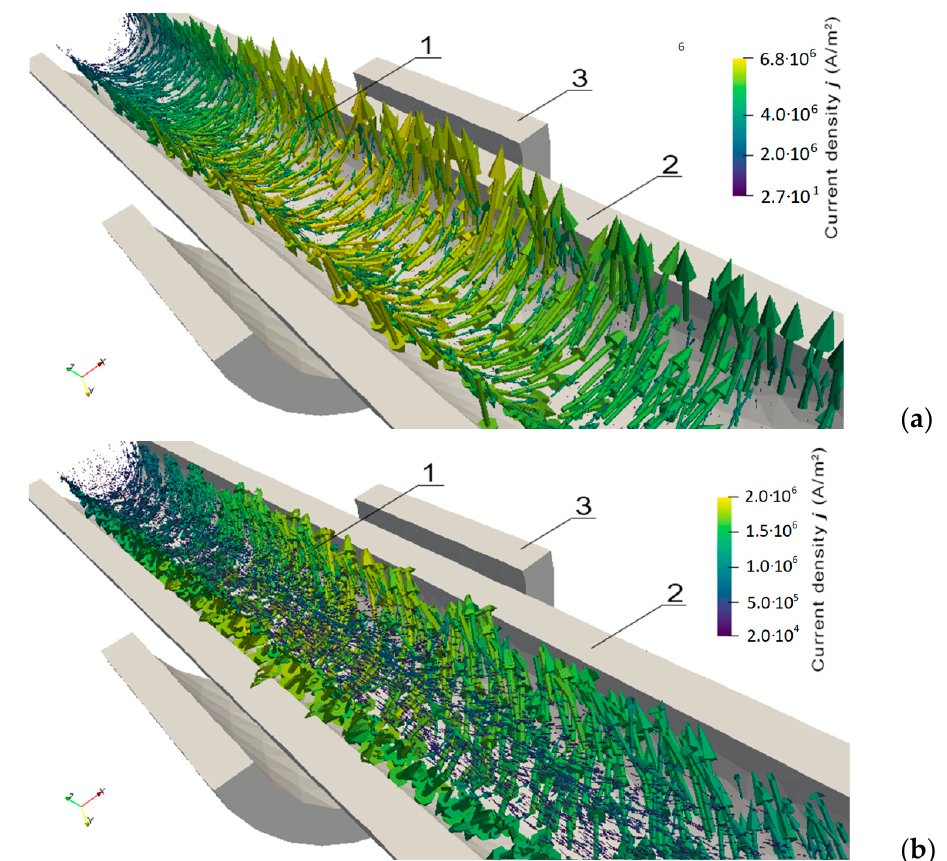
Figure 5. A cross ‐ section view of the eddy current vectors along the shaft’s axis for different values of torque M : ( a ) M = 0 Nm, ( b ) torque M = 1.3 Nm; 1—shaft (transparent), 2—magnetizing coil, 3—sensing coil.